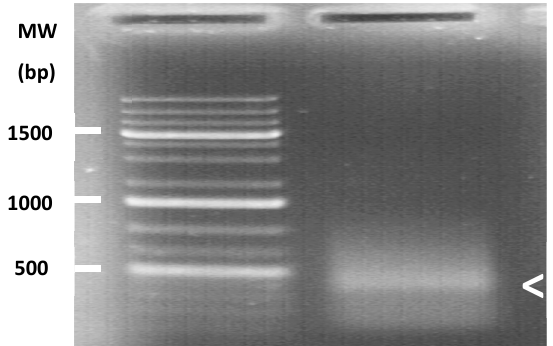
Figure 7. Identification of the transcription starting site of ORF2 ( ns gene) of the TuaDV by 5’ RACE PCR. Agarose gel showed a major amplicon at ~500 bp (white arrowhead). The amplicon was sequenced to recover the 5’ end sequence.